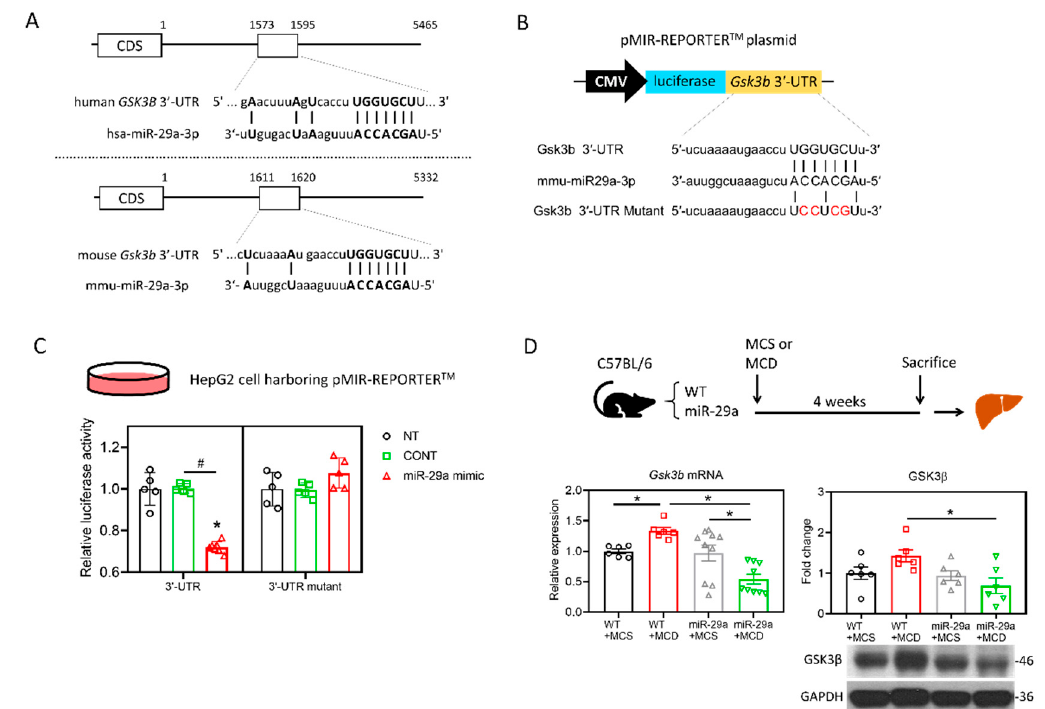
Figure 3. miR-29a suppresses GSK3 β expression by direct binding to its 3 ′ UTR. ( A ) Sequence of hsa-miR-29a-3p and its putative binding sites at 3’UTR of human GSK3B and mouse Gsk3b mRNAs. CDS, coding sequence. Open rectangles represent the region spanning putative miR-29a-3p binding sites. Base-paired nucleotides between 3 ′ UTR and miR-29a-3p are presented in the upper case. ( B ) A schematic representation of the plasmid for cytomegalovirus (CMV)-driven luciferase reporter assay. 3 ′ -UTR of Gsk3b or Gsk3b mutant was chemically synthesized into the pMIR-REPORT TM luciferase plasmid. Base-paired nucleotides are presented in upper case, while those in red denotes mismatched nucleotides. Plasmid was introduced into human hepatocyte cell line HepG2, followed by transfection of miR-29a mimic, miR negative control or no-treatment. ( C ) Suppression of reporter activities by miR-29a-3p overexpression in HepG2 cells. Cells were no treated (NT) or treated with miR negative control (CONT) or miR-29a mimic for 24h. Five independent experiments for each group were conducted. * p < 0.05 compared with CONT. # p < 0.05 between indicated groups. ( D ) Gsk3b mRNA level was determined by qRT-PCR. GSK3 β protein abundance was measured by Western blot. Data collected from six to ten independent experiments per group are expressed as mean ± SE. * p < 0.05 between indicated groups. MCD, methionine/choline-deficient; MCS, methionine/choline-sufficient.